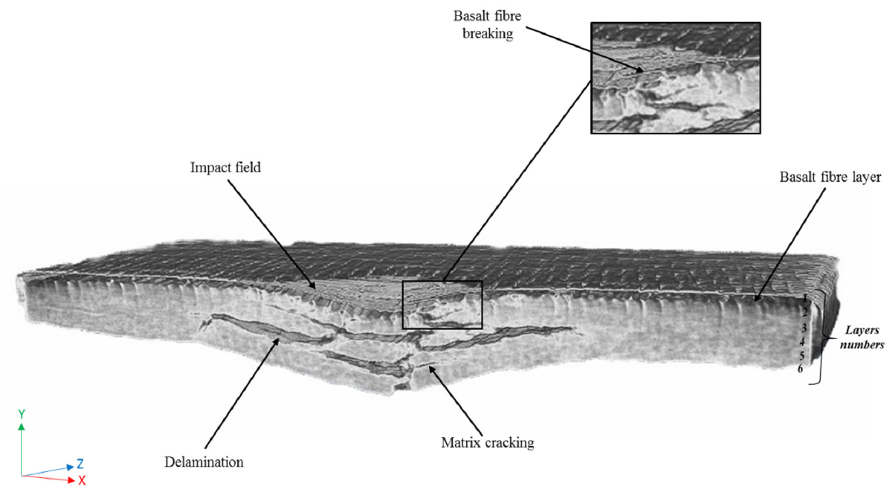
Figure 17. Micro CT scan picture of a flax/basalt hybrid composite specimen (half-view) after an impact test, with a 50 J impact energy, with different failures displayed by the specimen.